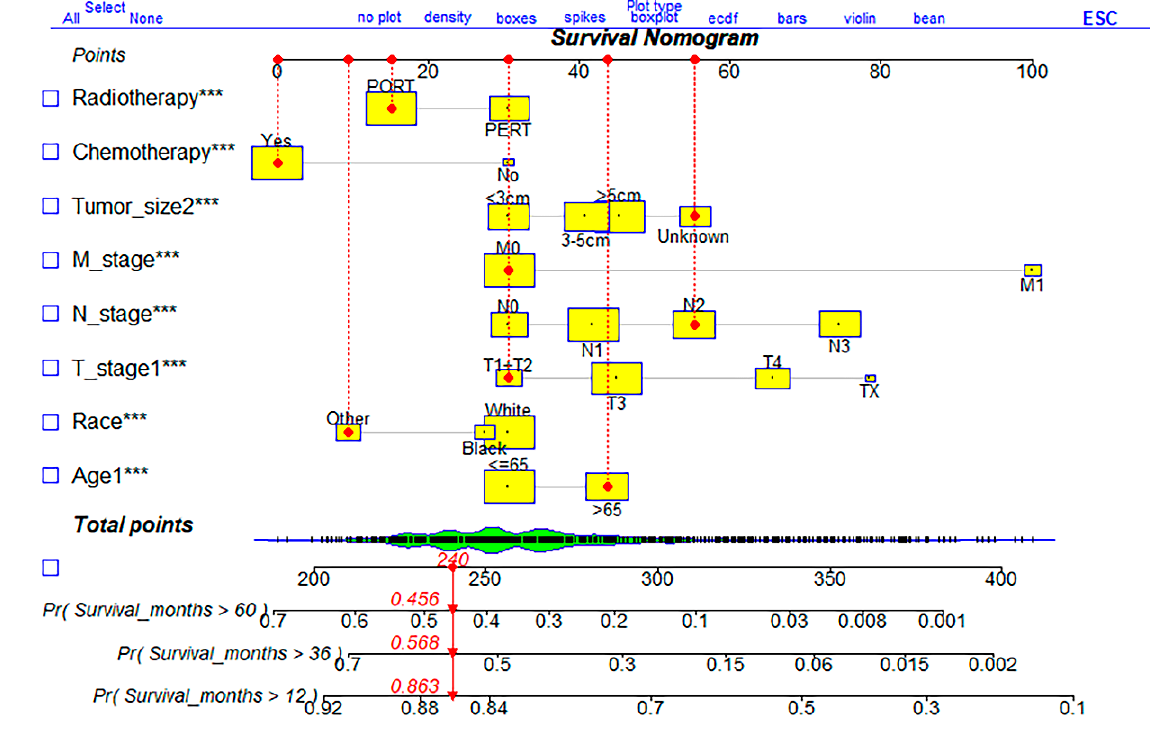
Figure 4. The dynamic nomogram for predicting 1-, 3- and 5-year OS of advanced GC patients. Figure 4. A dynamic nomogram for predicting 1-, 3- and 5-year probabilities of gastric cancer pa- OS: overall survival; GC: gastric tients was established.